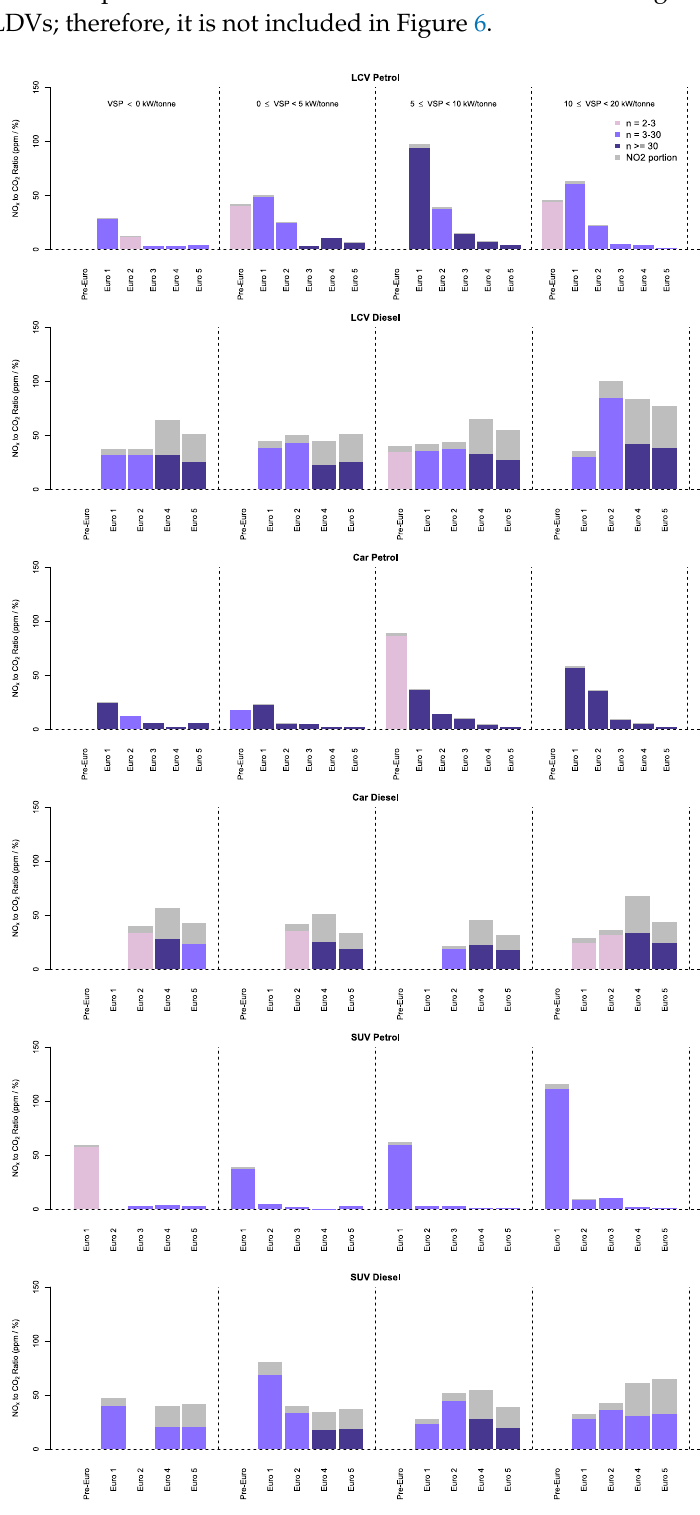
Figure 6. Mean NO x -to-CO 2 ratios for petrol and diesel light duty vehicles (LDVs) by vehicle type and VSP/Euro class.